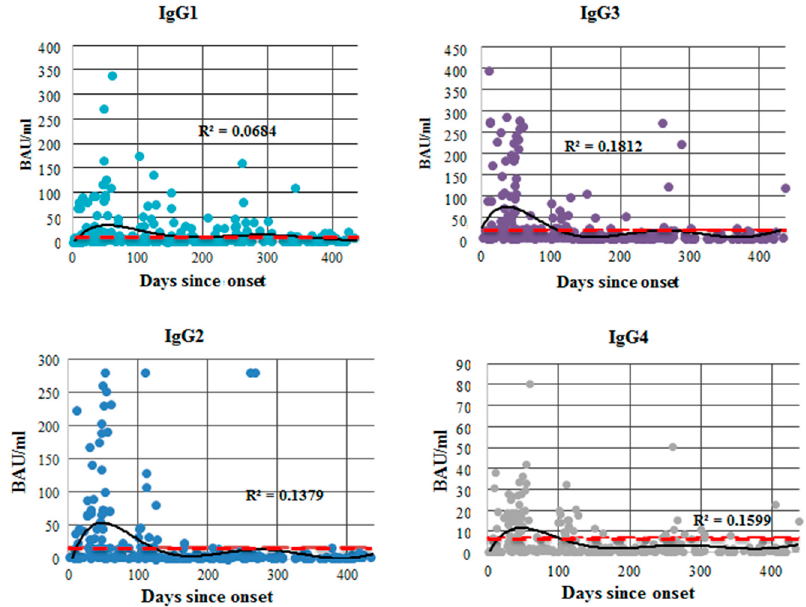
Figure 6. Total anti-S protein (RBD) IgG antibody dynamics (ELISA) by subclass, as a function of time since COVID-19 onset for 312 individual patients. The range was from 1 to 438 days. Concentration is presented in BAU/mL. The red line represents the cut-off value for this specific ELISA kit. The black line is the trend. R 2 values are shown on the graph.